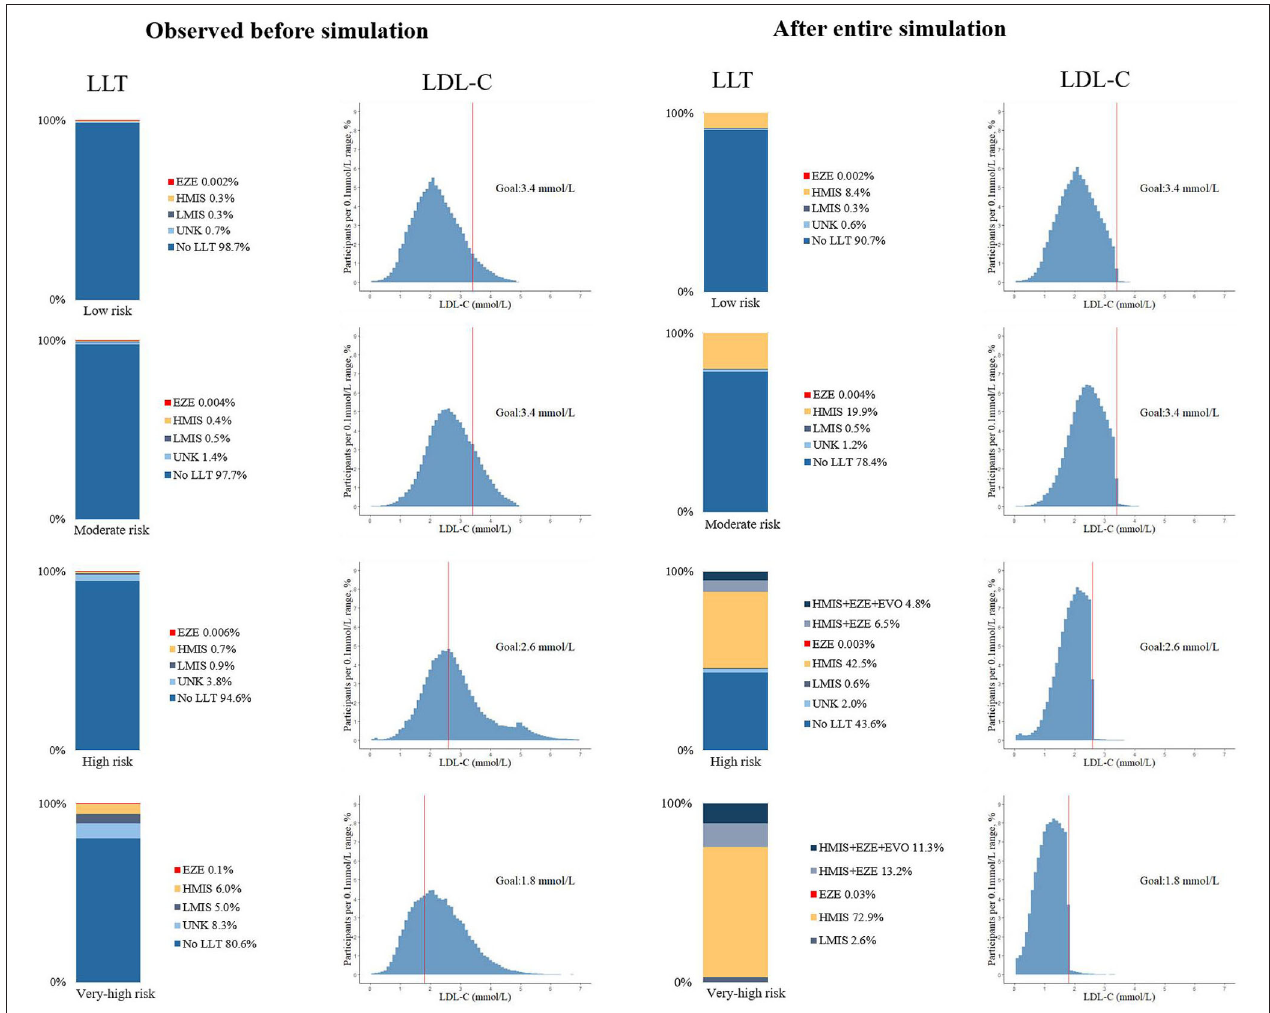
FIGURE 3 | Use of lipid-lowering medications and distribution of LDL-C levels before and after the lipid-lowering therapy simulation, by 10-year ASCVD risk stratifications. UNK, unknown name or not guideline-recommended medications; HMIS, maximized uptake of moderate-intensity statins, including: atorvastatin 20mg, simvastatin 40mg, rosuvastatin 10mg, pravastatin 40mg, pitavastatin 4mg, lovastatin 40mg, or fluvastatin 80mg; LMIS, statins with doses less than HMIS; EZE, ezetimibe; EVO, evolocumab 140mg,